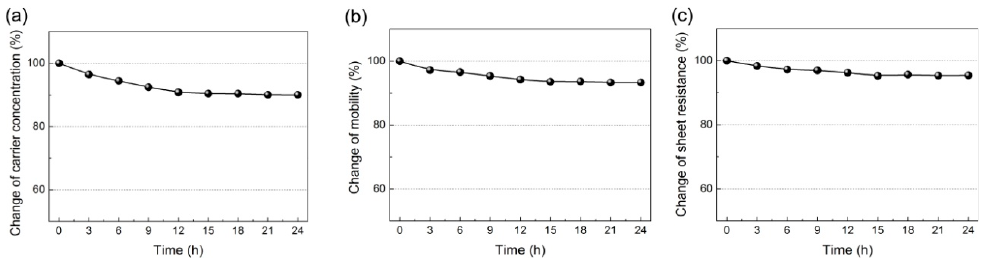
Figure 2. The changes of ( a ) carrier concentration; ( b ) mobility and ( c ) sheet resistance of graphene films as a function of the incubation time in DNA probe/1× TE buffer.